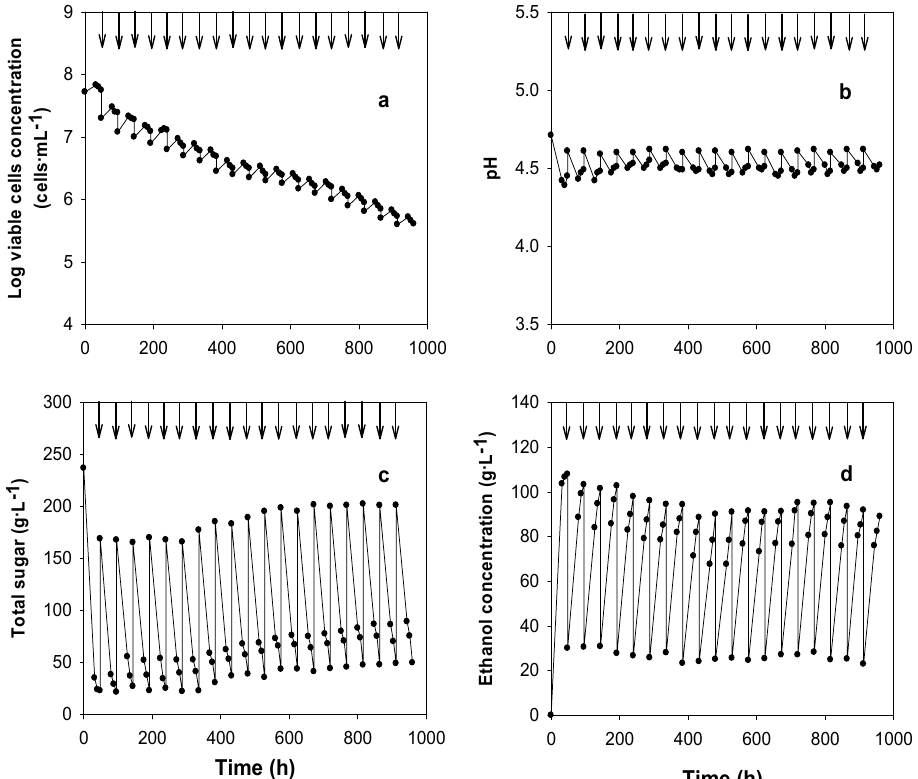
Figure 4. Fermentation parameters during 20 cycles of repeated-batch ethanol production from sweet sorghum juice containing 240 g·L − 1 of total sugar and 21 g·L − 1 of DSY (dried spent yeast) in the 2-L fermenter. ( a ) log viable yeast cells; ( b ) pH; ( c ) total sugar; ( d ) ethanol concentration. The arrows indicate the start time of each